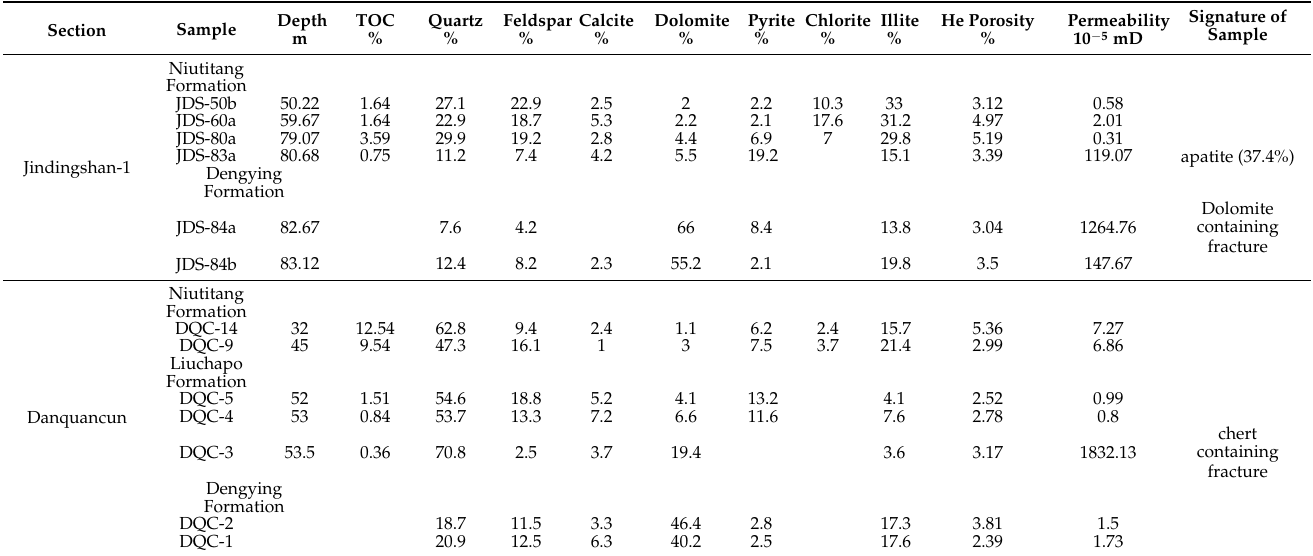
Table 2. Mineralogy compositions, He porosities and permeabilities of the Niutitang shale samples in the Jindingshan-1 (JDS-1) well and Danquancun (DQC) section.